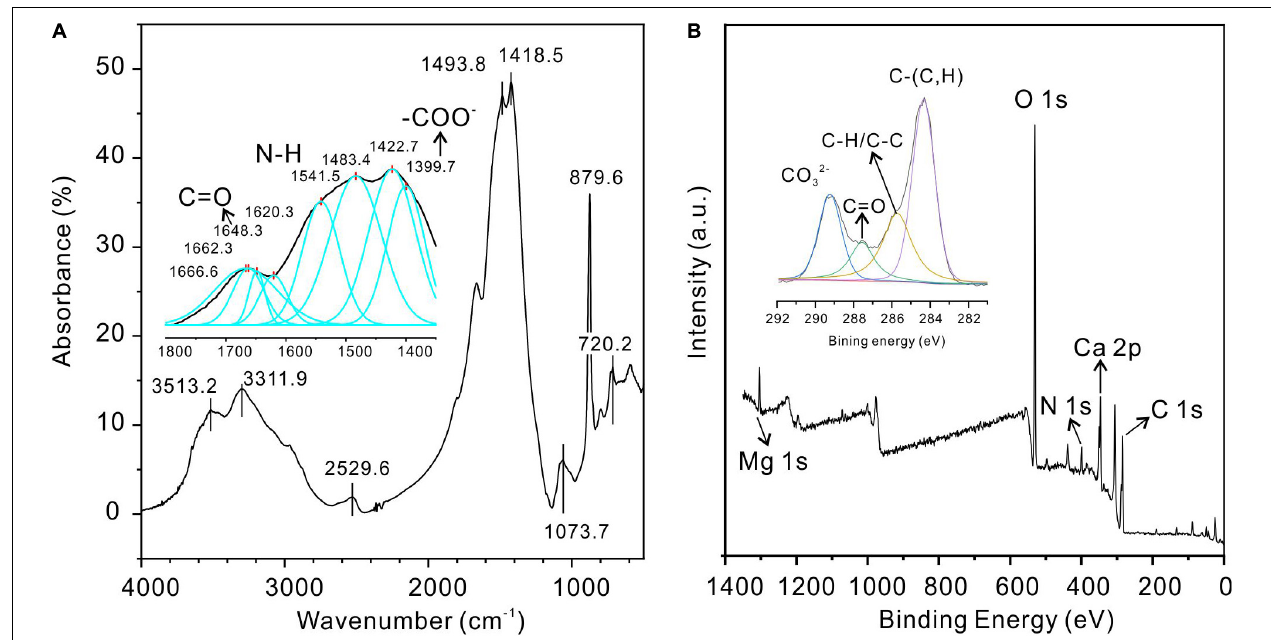
FIGURE 11 | Fourier-transform infrared spectroscopy (FTIR) and XPS analyses of protodolomite induced by Vibrio harveyi QPL2. (A) FTIR; (B) XPS.